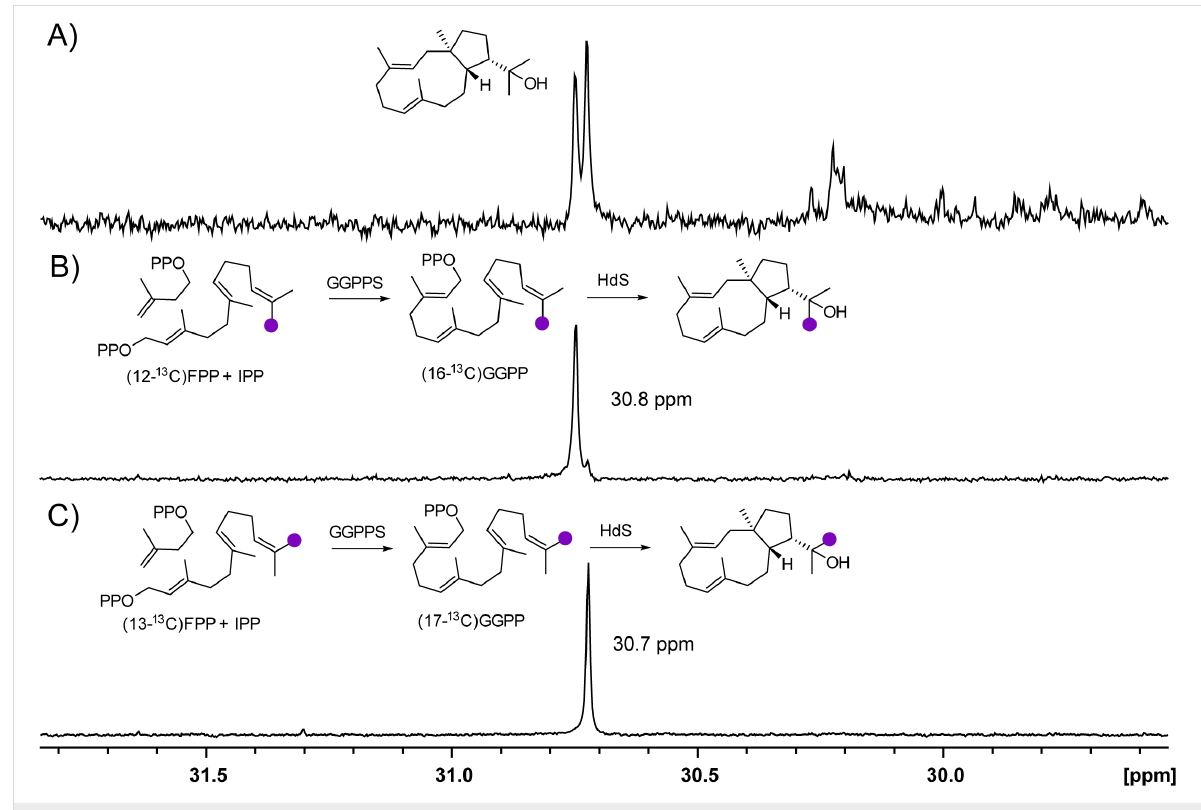
Figure 5: Partial 13 C NMR spectra of A) unlabeled 3 , B) ( 13 C 1 )- 3 arising from incubation of HdS and GGPPS with (12- 13 C)FPP + IPP, and C) ( 13 C 1 )- 3 arising from incubation of HdS and GGPPS with (13- 13 C)FPP + IPP. Labelled carbons are indicated by purple